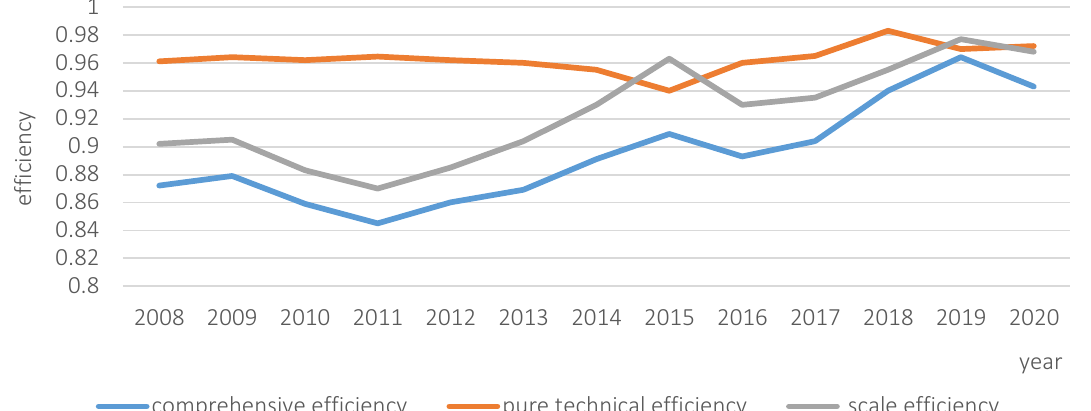
Figure 2. Change trend of government funding efficiency (funding efficiency refers to DMU efficiency, which is between 0-1) in higher education in